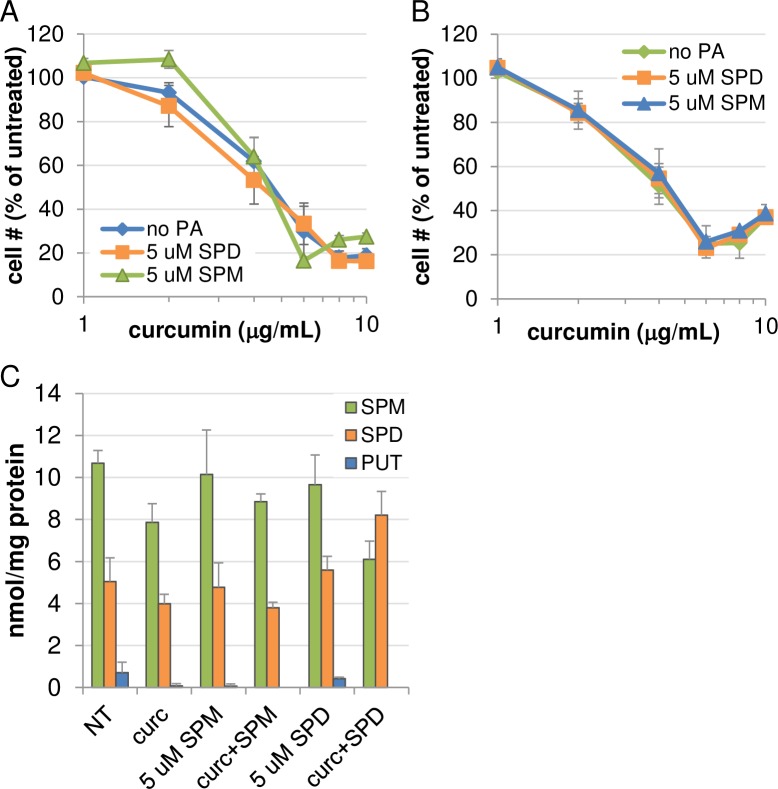
Polyamine rescue experiments.AGS (A) or HCT116 (B) cells were treated with curcumin for 48 hours in the presence or absence of spermidine or spermine and the bovine serum amine oxidase inhibitor aminoguanidine. MTS assays revealed that exogenous polyamines failed to protect cells from the growth inhibitory effects of curcumin. Data points indicate the means of at least 2 individual experiments, each measured in triplicate, with error bars representing SEM. (C) HPLC analysis of cotreated AGS cells confirmed uptake of spermine and spermidine into the cells, indicating that curcumin did not interfere with polyamine transport. Columns depict the means; error bars indicate SEM; n = 2, each measured in duplicate.